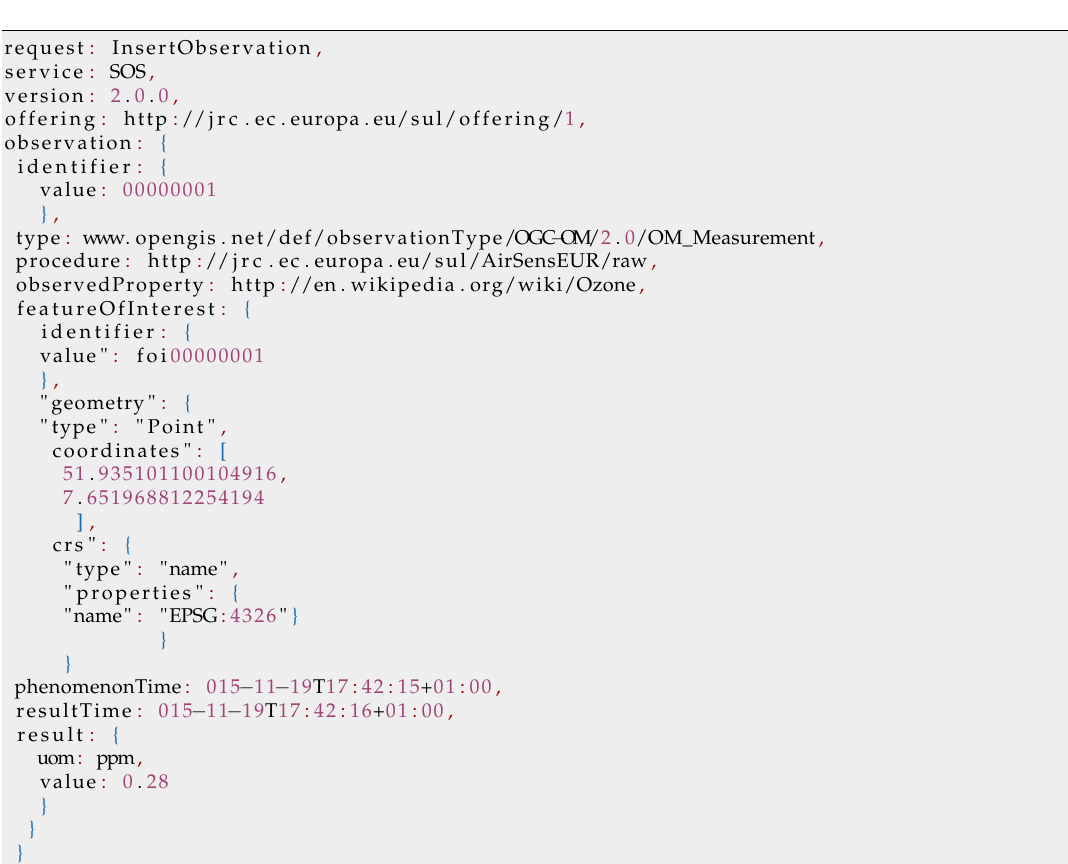
Figure 4. Sample InsertObservation JSON